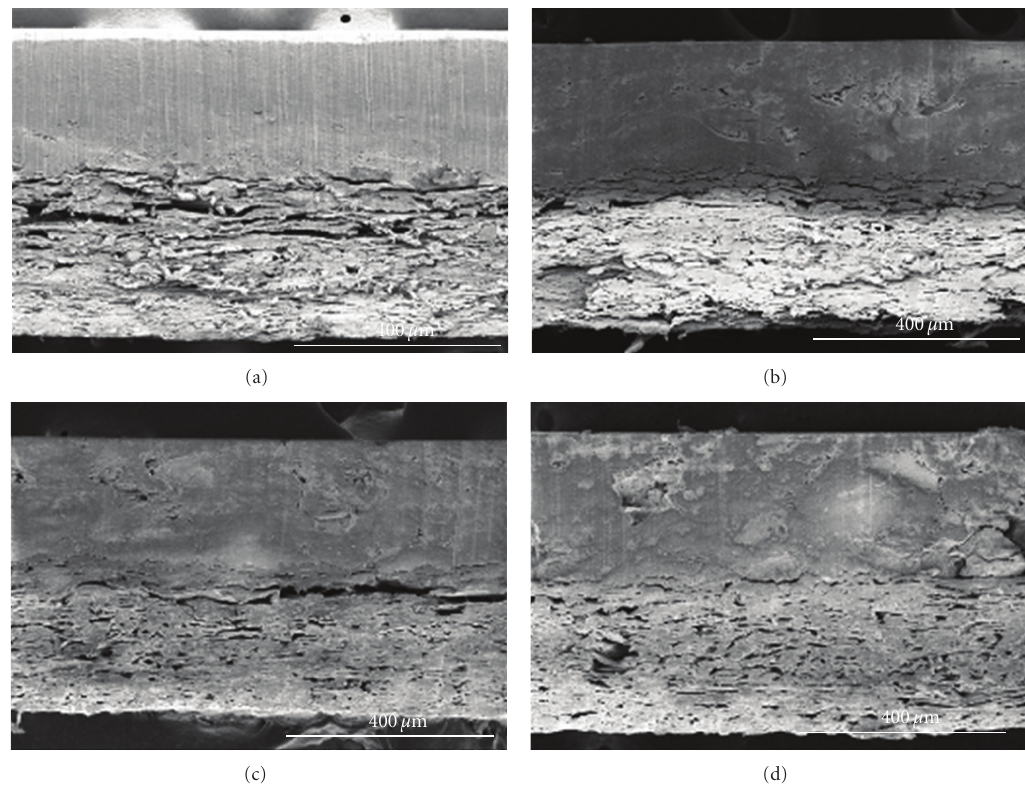
Figure 3: Cross-sections of the samples containing 20wt.% plasticizer with (a) 0 wt.%, (b) 25wt.%, (c) 50wt.%, and (d) 75 wt.% OA. The top denser part is the gluten layer, and the bottom porous part is the paperboard.